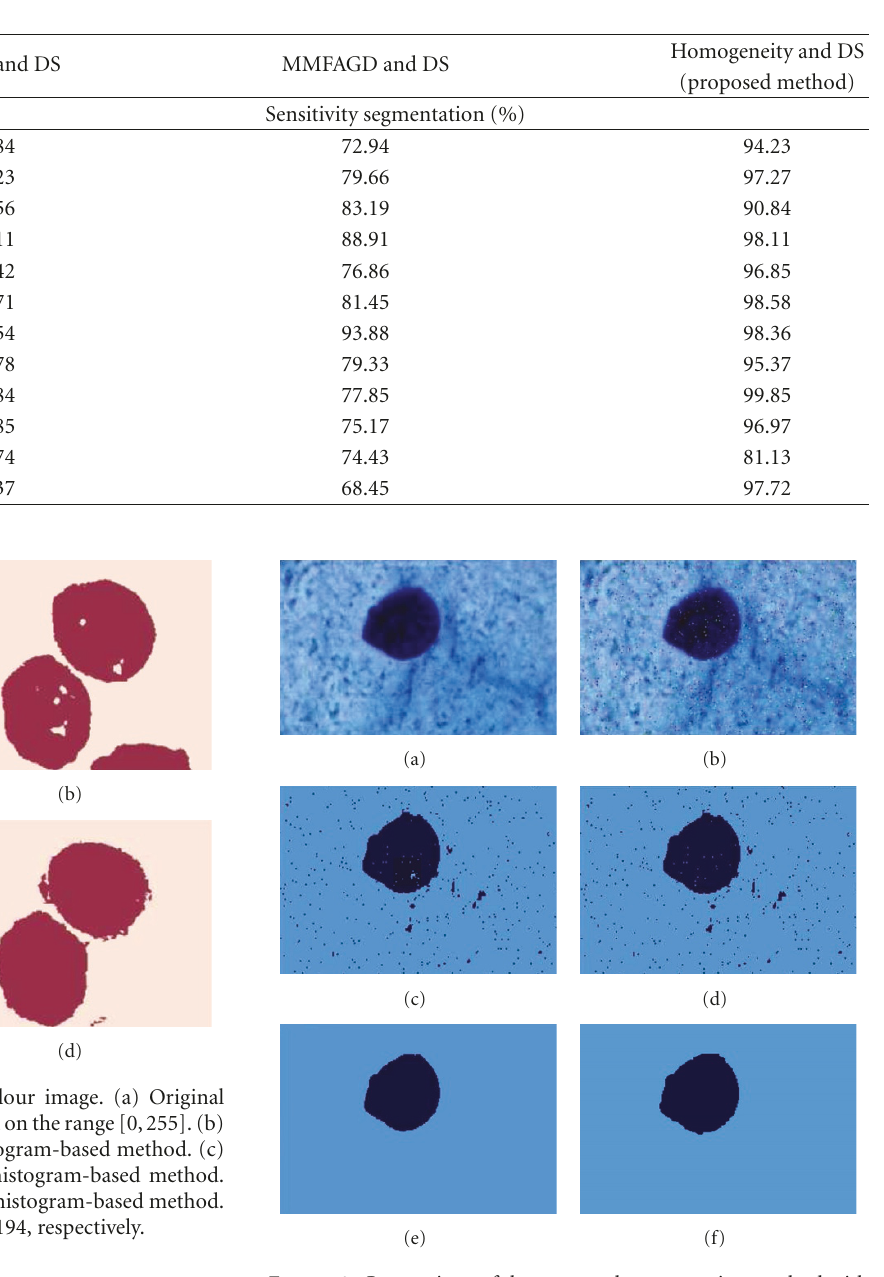
Figure 3: Comparison of the proposed segmentation method with other existing methods on a medical image (2 classes, 1 cell). (a) Original image with RGB representation (256 × 256 × 3), (b) colour cell image disturbed with a “salt and pepper” noise, (c) segmentation based on MMFD and DS (d) segmentation based on MMFAGD and DS, (e) segmentation based on homogeneity and DS, and (f) reference segmented